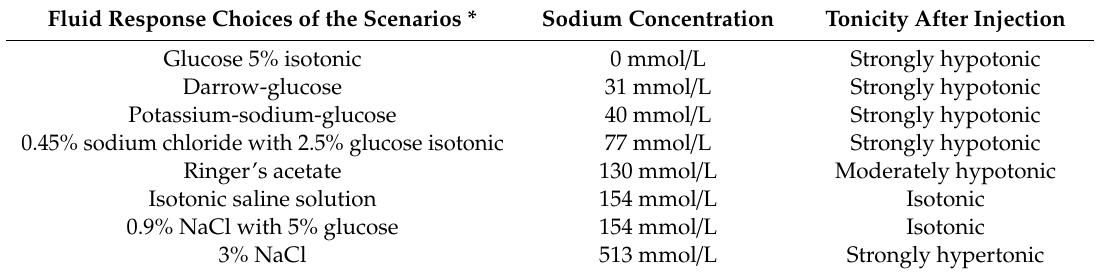
Table 1. IV fluid response choices indicating sodium concentration and tonicity after injection. Fluid Response Choices of the Scenarios